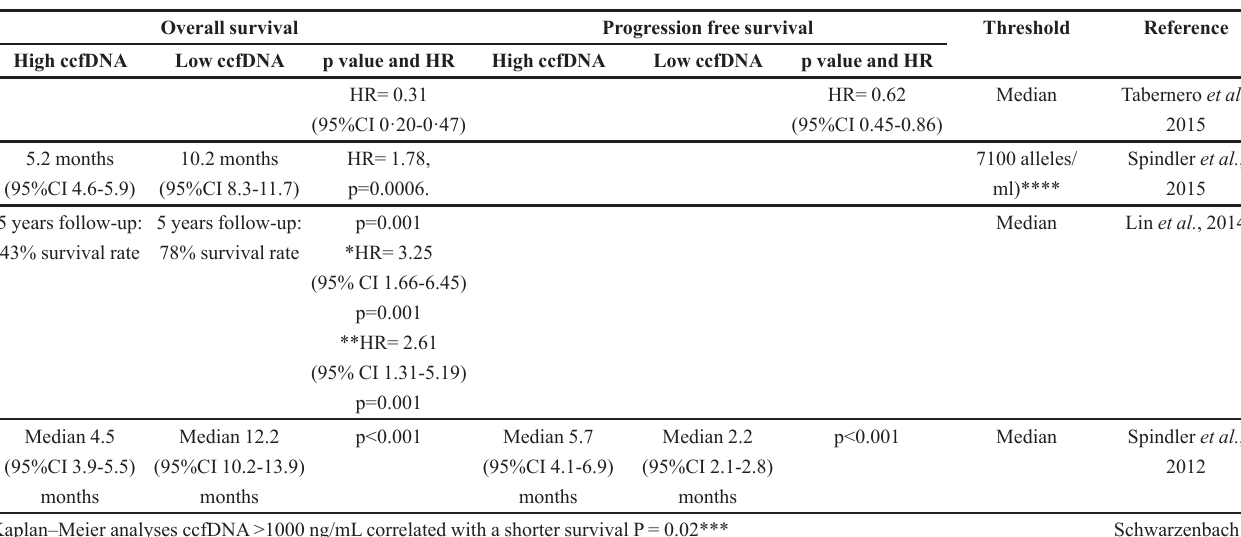
TABLE VIII - Results for the ccfDNA quantification biomarkers for the CRC